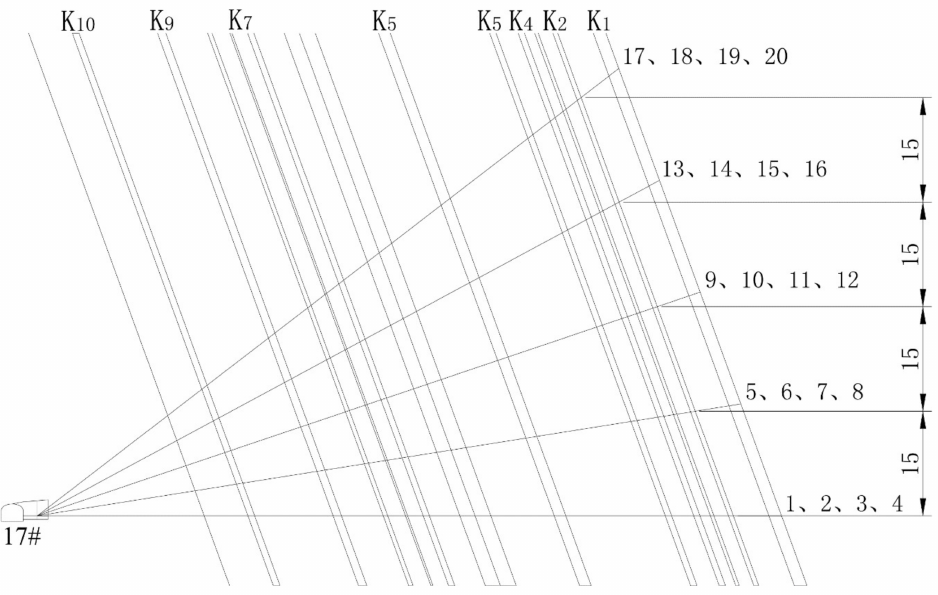
Figure 19. Enlarged view of borehole section layout.